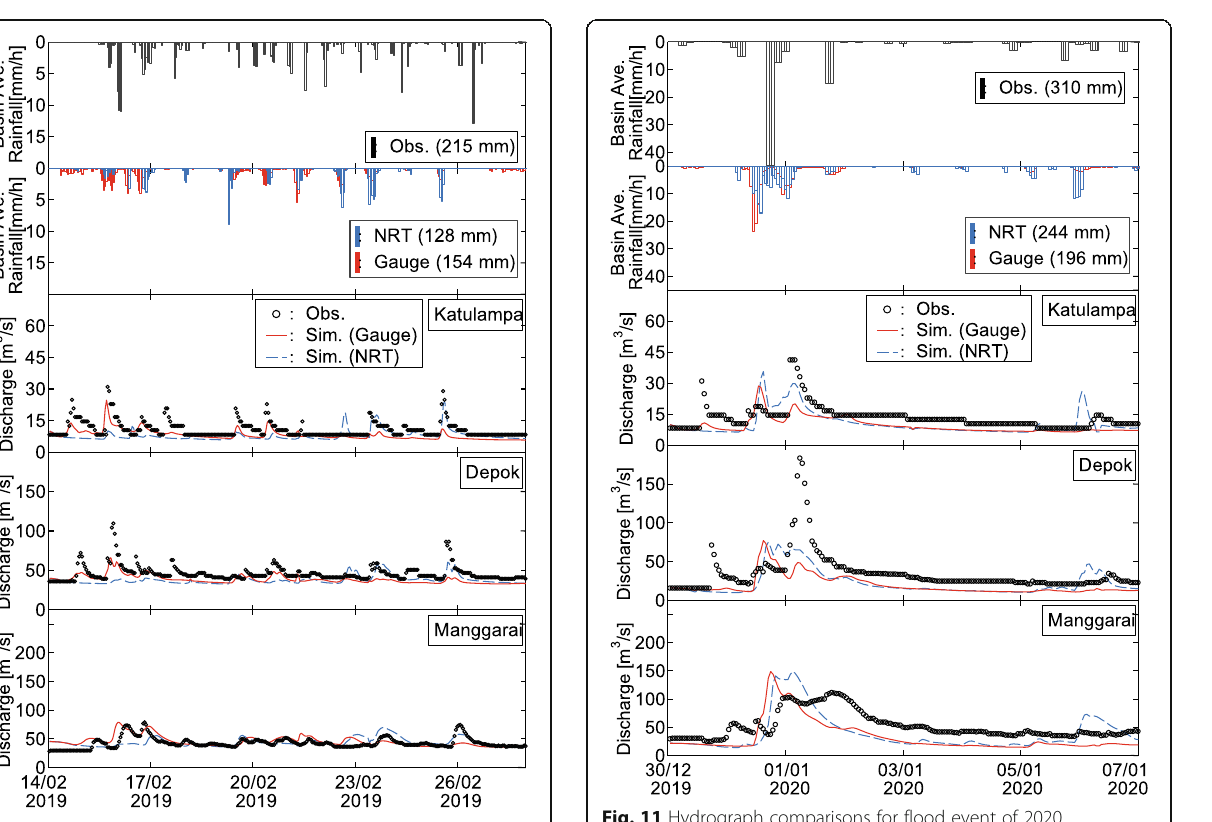
Fig. 10 Hydrograph comparisons for flood event of 2019